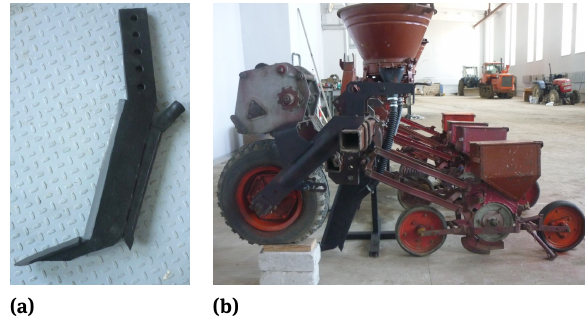
Figure 11: DPFA and Seeder prototype,